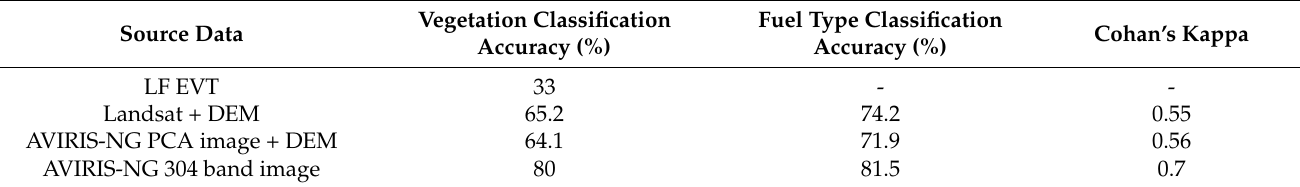
Table 3. Classification accuracy for vegetation and fuel type classification from different source data at BCEF. “-“ indicates data wasn’t available for calculation.